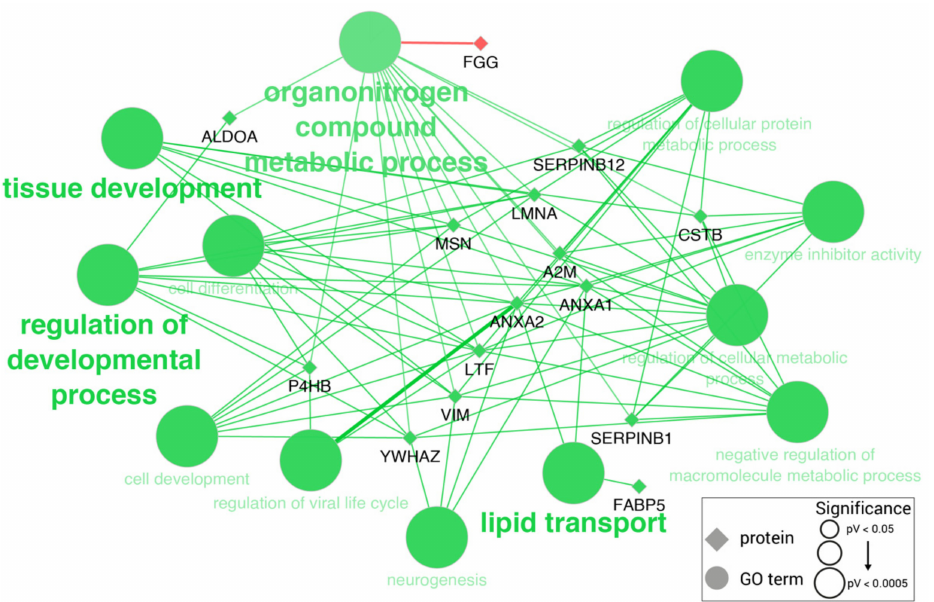
Figure 1. Significantly enriched GO terms among differentially expressed proteins in the saliva of pigs with sepsis. Edges link proteins (diamonds) to their associated GO terms (circles). Proteins are colored in green if overexpressed or in red if down-expressed. GO terms are colored accordingly to the proportion of over-/down-expressed proteins. GO term shape and font size is proportional to GO term significance, but all included ones showed a p -value < 0.05. Table 2. Differentially expressed serum proteins in pigs with experimentally-induced sepsis. Mean Abundances Fold Changes